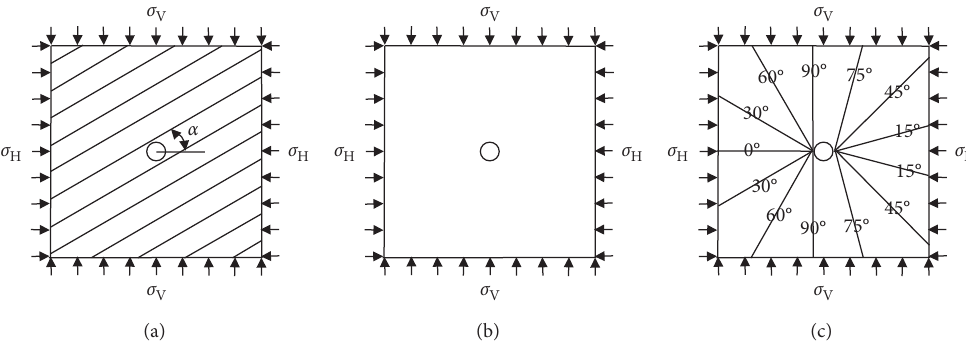
Figure 4: Schematic of the model set. (a) Parallel joint model. (b) No-joint model. (c) Multi-dip angle joint Table 1: Physicomechanical parameters of the rock and joint in the simulations. Parameters Unit Rock Joint Heterogeneity index ( m ) Young’s modulus ( E ) Poisson ratio ( v )